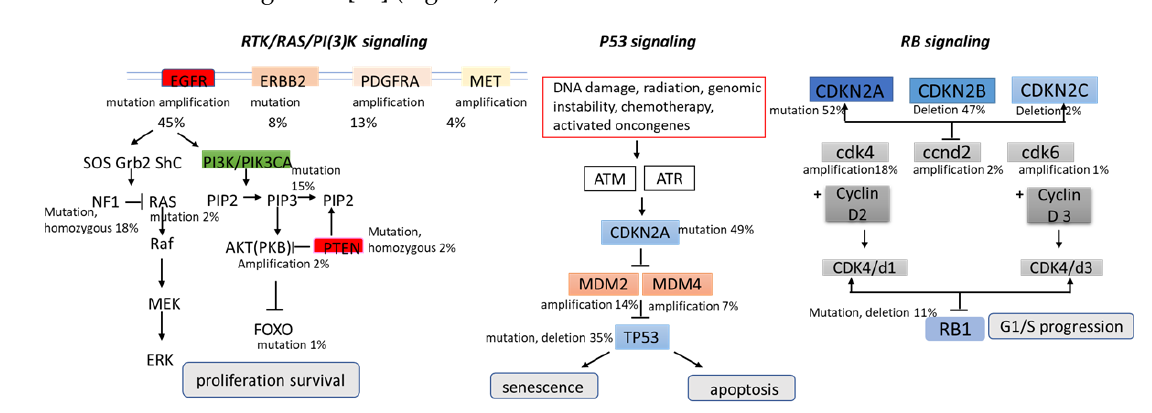
Figure 2. Major signaling pathways involved in the pathogenesis of glioblastomas.